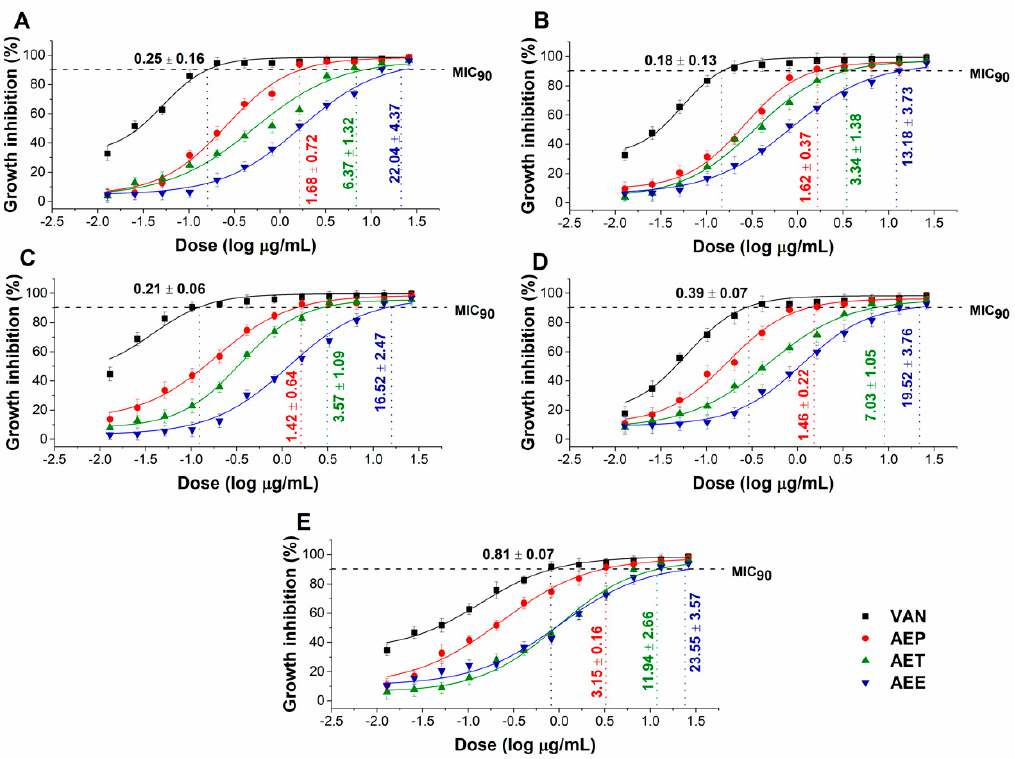
Figure 3. Minimum inhibitory concentration (MIC 90 ) of AEP, AET, AEE, and vancomycin (VAN) in µg/mL on E. coli ( A ), S. aureus ( B ), B. subtilis ( C ), P. aeruginosa ( D ), and S. pyogenes ( E ). Six independent experiments each with three technical replicates were performed (mean ± SD).